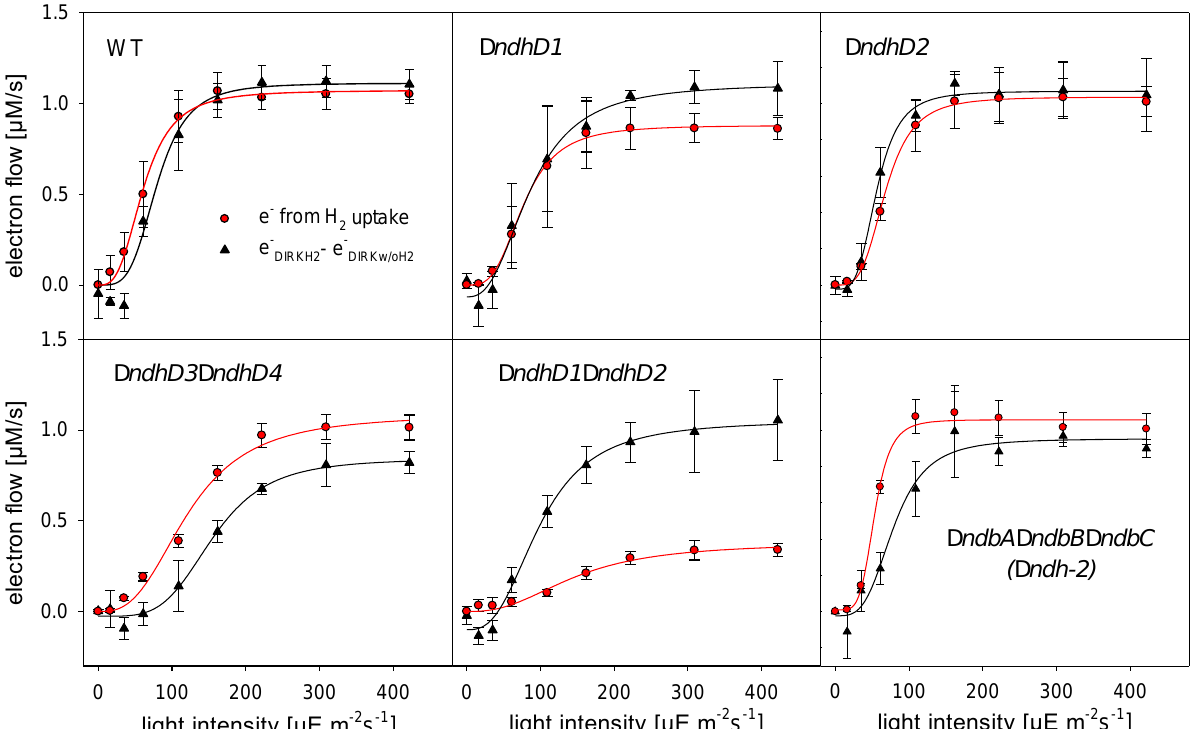
Figure 4. Parallel measurements of H 2 consumption (by a hydrogenase electrode) and electron flow through PSI by DIRK (dark interval relaxation kinetics) measurements of different ndhD deletion strains and the deletion strain of the type 2 dehydrogenase (Δ ndbA Δ ndbB Δ ndbC ). The black triangles and the black lines indicate the increase of electron flow through PSI due to the addition of H 2 and the red circles and red lines indicate the number of electrons generated by H 2 oxidation. The rates are given as µM electrons/s at a cell density of OD 750 = 5.7. The error bars indicate the standard deviation of at least three independent cultures.